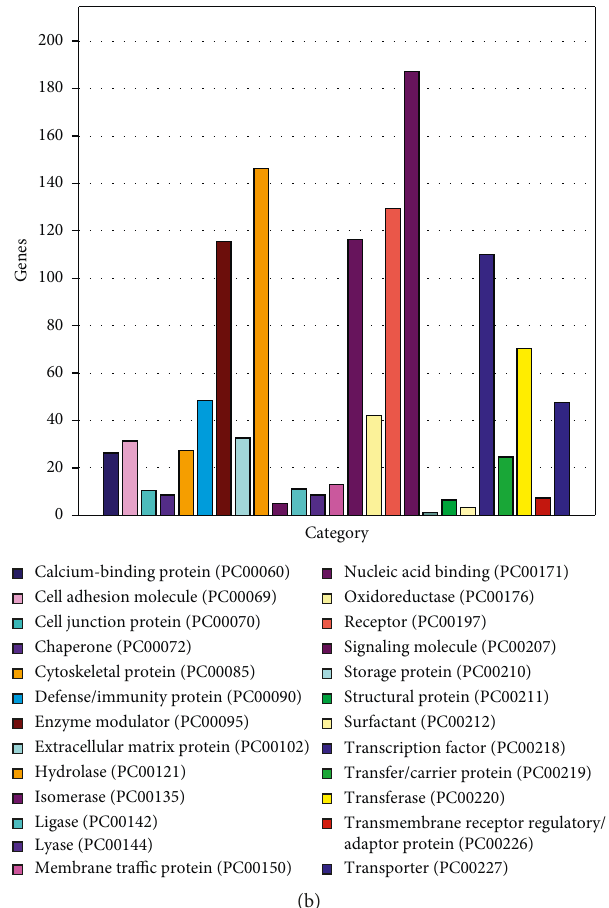
Figure 3: Bioinformatics analysis on the list of human fibrosis-related genes. (a) Biological pathway analysis with Reactome (http://www. reactome.org/). (b) Protein class analysis with PANTHER